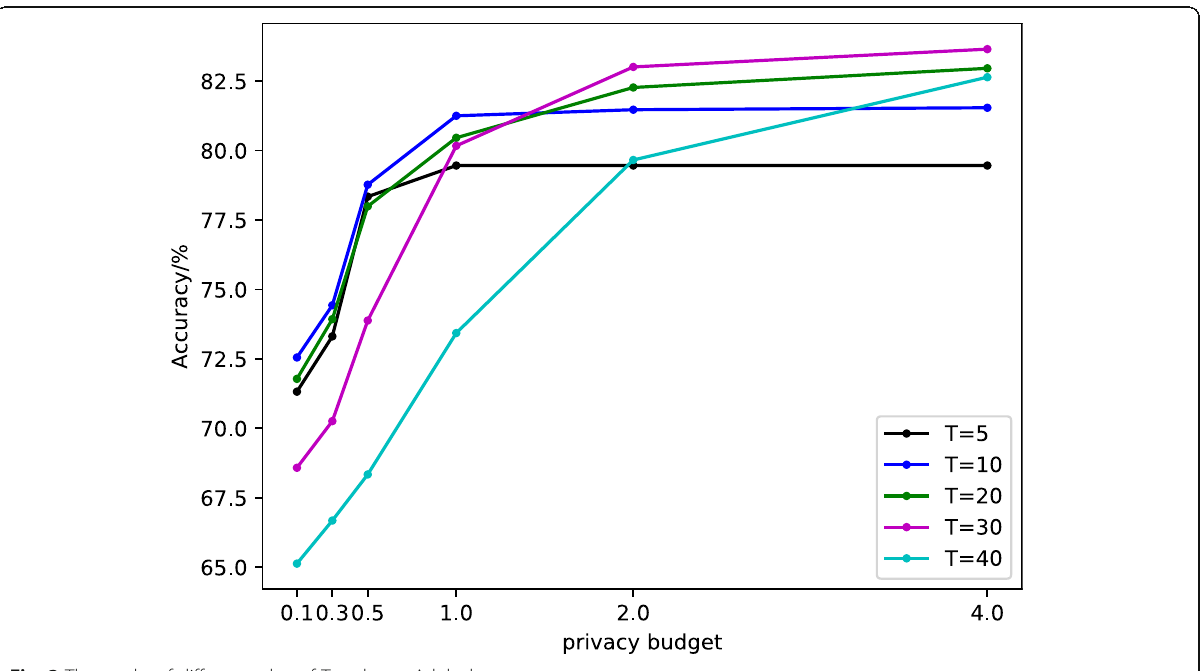
Fig. 3 The results of different value of T and ε on Adult